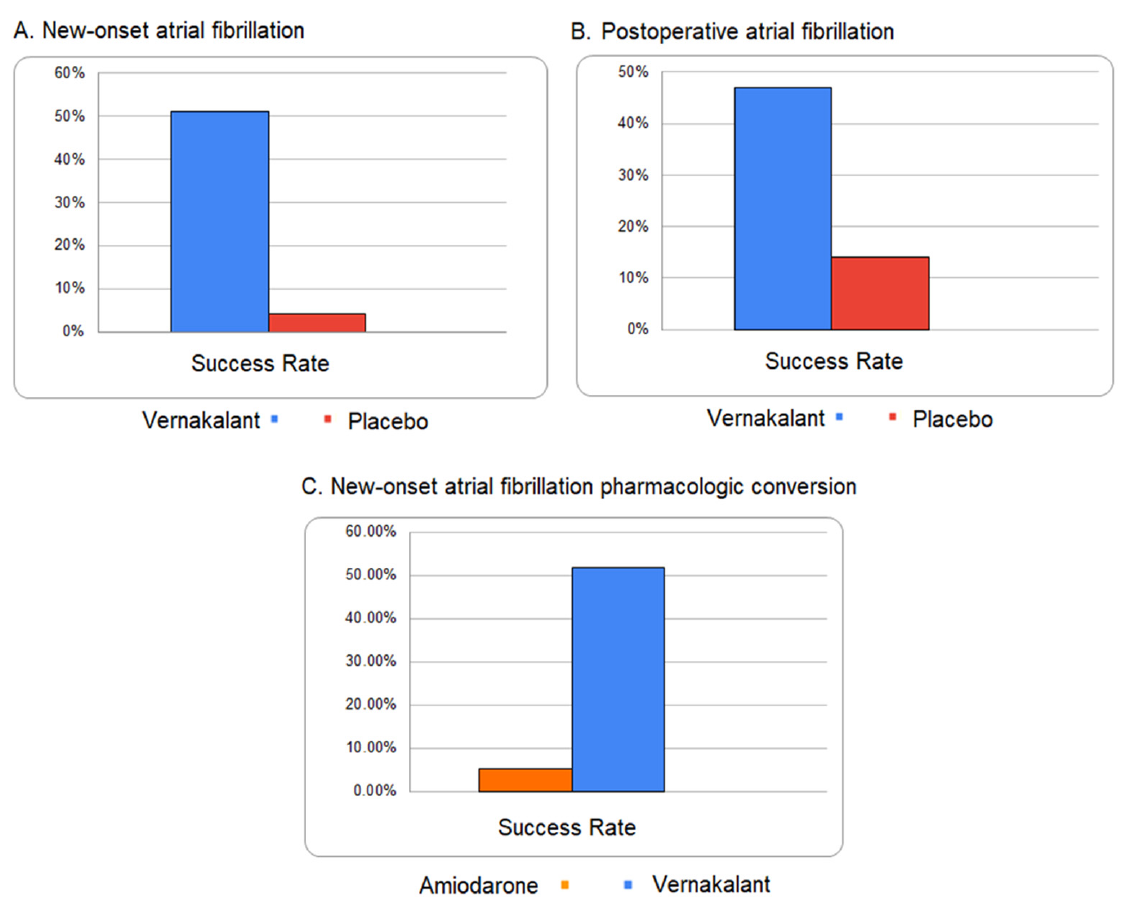
Figure 2. Comparative success rates for vernakalant (based on information provided by the European Medicines Agency [18]). ( A ) New-onset AFib—success rate of vernakalant versus placebo; ( B ) postoperative AFib—success rate of vernakalant versus placebo; ( C ) new-onset AFib—success rate of amiodarone versus vernakalant.